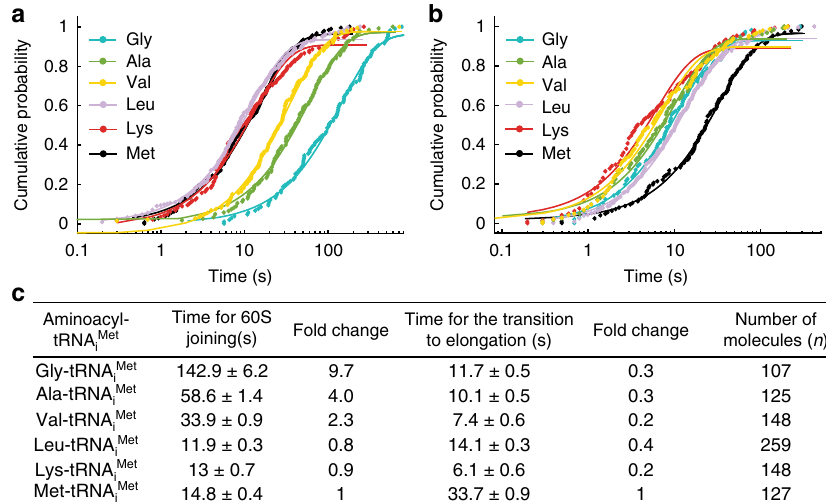
Fig. 4 Kinetics of 60S subunit joining and the subsequent transition into elongation in experiments performed with mis-acylated tRNA i Met . The cumulative probability distributions of the dwell times for 60S joining ( a ) and the transition to elongation ( b ) from experiments performed at 3 mM free Mg 2 + and 20 °C with the model mRNA and unlabeled eIF5B. Data points were fi tted to a single-exponential equation with the mean times reported in ( c ). Errors represent 95% con fi dence intervals, and the number of molecules analyzed ( n ) are listed in ( c